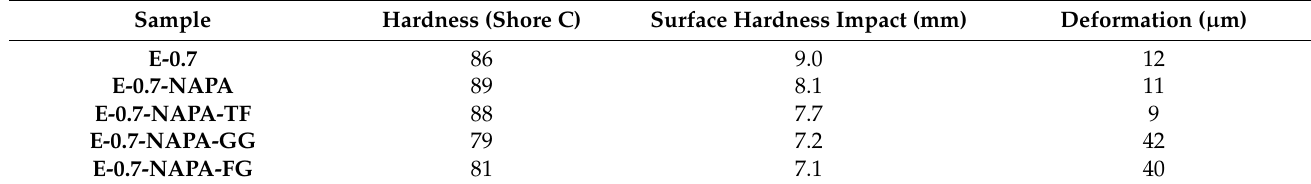
Table 6. Surface hardness tests